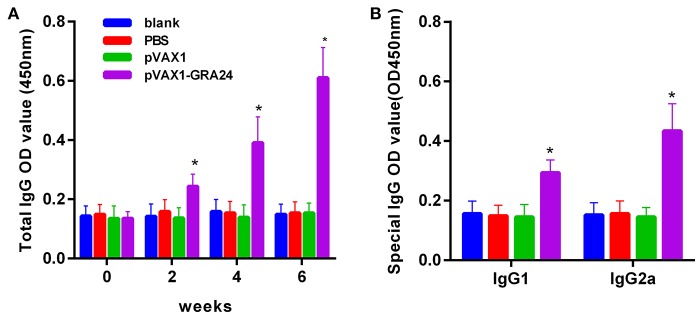
DNA vaccination with pVAX1-GRA24 induced dynamic changes in humoral responses in BALB/c mice. (A) Total IgG; (B) IgG1, IgG2a. The OD450 value of total IgG were detected on 0, 2, 4, and 6 weeks post-vaccination. The OD450 value of IgG subclass (IgG1, IgG2a) were detected at 6 weeks post-vaccination. Data are expressed as mean ± SD (n = 20) from three independent experiments. Asterisks (*) indicate statistically significant differences (p < 0.05) compared with the control groups.